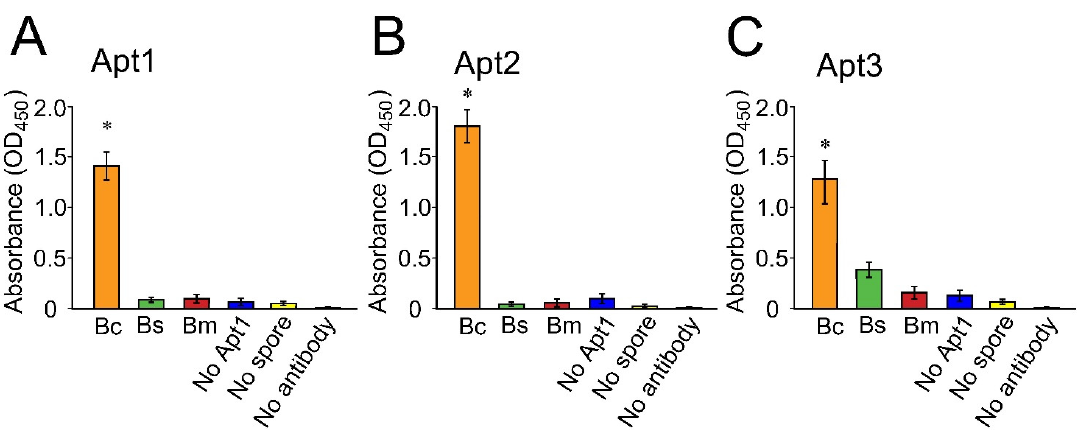
Figure 3. Binding affinity of three aptamers to different Bacillus spores at 10 5 spores/mL using a sandwich ELISA strategy. ( A ) Apt1, selected against B. thuringiensis spores. ( B ) Apt2, selected against B. anthracis spores. ( C ) Apt3, selected against B. anthracis spores. All three aptamers showed binding affinity to B. cereus spores. This experiment was repeated thrice. Error bars represent standard deviations. Asterisks indicate statistically significant differences with non-BC group spores or controls and were determined with one-way ANOVA followed by Tukey post-hoc analysis (* p < 0.005). Abbreviations: Bc, Bacillus cereus ; Bm, Bacillus megaterium ; Bs, Bacillus subtilis .